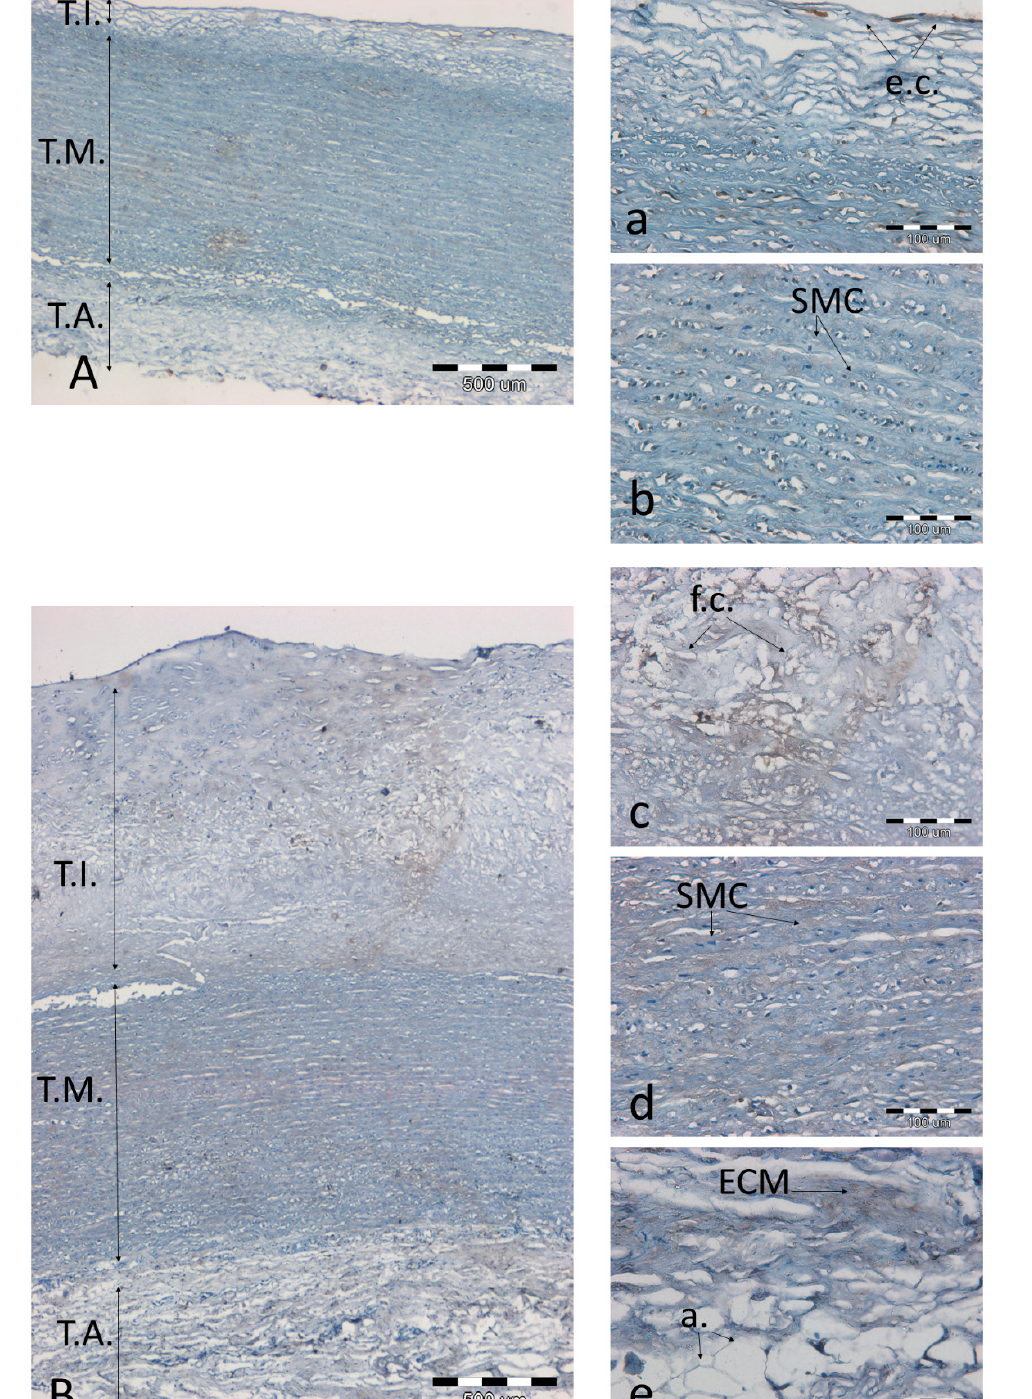
Figure 7. Immunodetection of the MMP ‐ 9 antigen in a representative artery with a low degree of atherosclerosis ( A ,( a , b )) and high degree of atherosclerosis ( B ,( c – e )). A , B —the entire aortic section, 40× magnification, scale bar 500 μ m; ( a – e )— magnification 200×, scale bar 100 μ m. Abbreviations in figures: T.A.—tunica adventitia; T.I.—tunica intima; T.M.—tunica media; ch.c.—cholesterol clefts; v.v.—vasa vasorum; f.c.—foam cells; SMC—smooth muscle cells; e.c.—endothelial cells; a.—adipocytes; ECM—extracellular matrix; MP—macrophages.